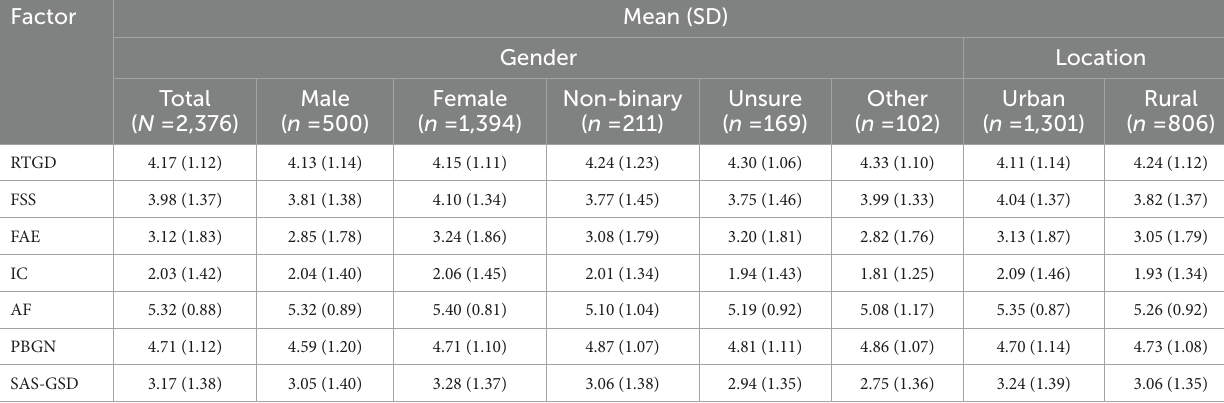
TABLE 1 Factor means and standard deviations for the total sample and by self-defined gender and location. Factor